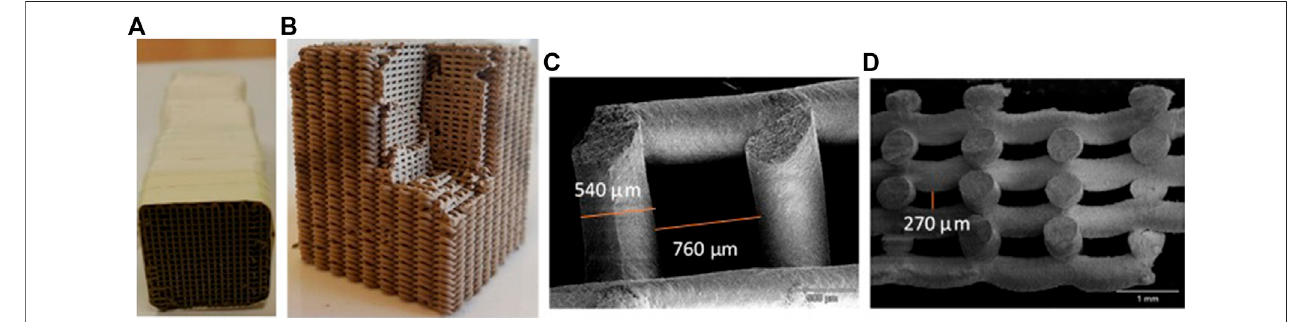
FIGURE1| Pictureof3DFD-printed zeoliticimidazolateframework-8 Monolith. (A) Monolithused forbreakthroughexperiments. Severalpieces werestackedand held together with Te fl on tape. (B) Side view showing the presence of channels in the radial direction. (C) Scanning electron microscopy-picture of the top-view of the monolith. (D) Scanning electron microscopy-picture of side view visualizing the radial gaps present in the